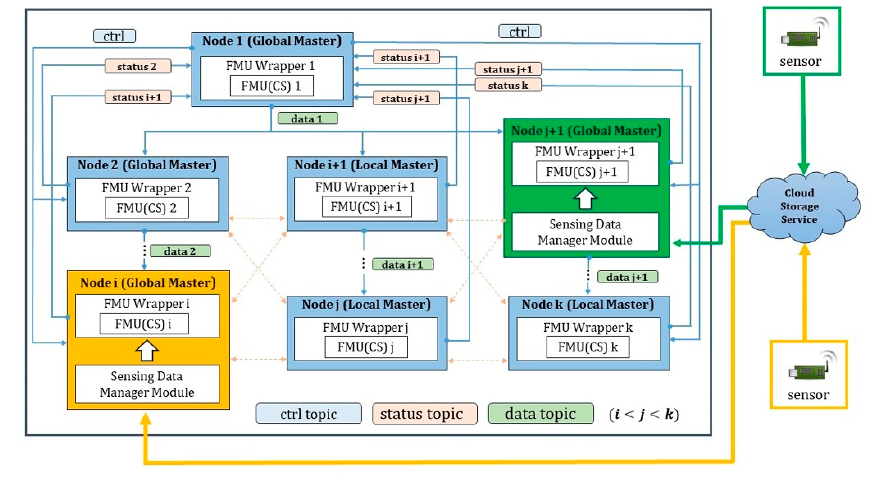
Figure 3. FMI-based distributed cyber physical system (CPS)-simulation framework.